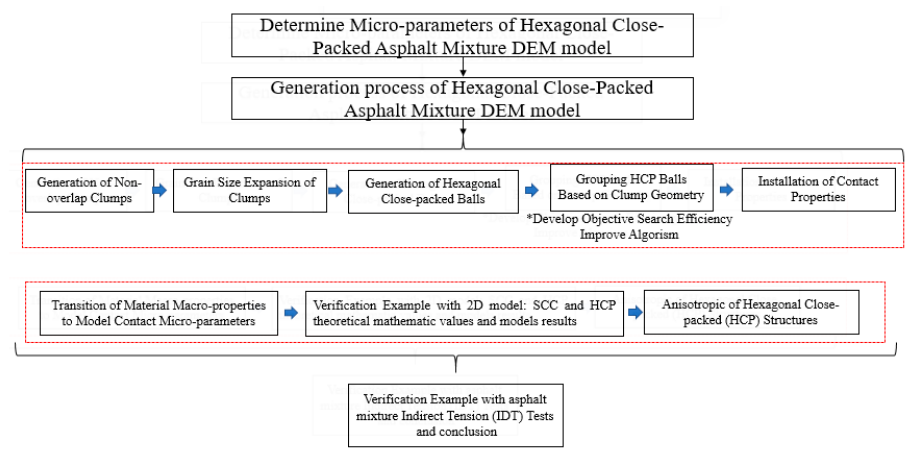
Figure 1. Research methodology in this research.